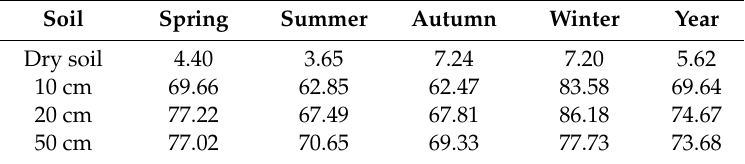
Table 2. Spatial distribution of relative soil moisture (%) in a continental river oasis area during 1992–2011. Soil Spring Summer Autumn Winter